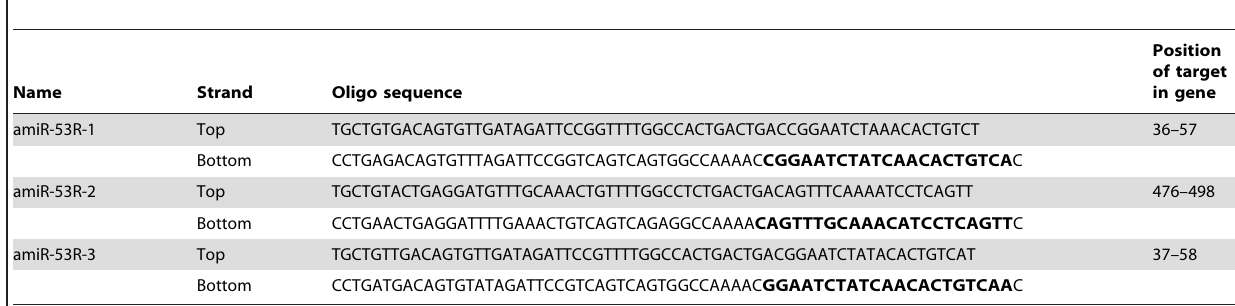
Bold letters represent sense sequences of engineered amiRNAs derived from the target gene. doi:10.1371/journal.pone.0010308.t001 PLoS ONE |